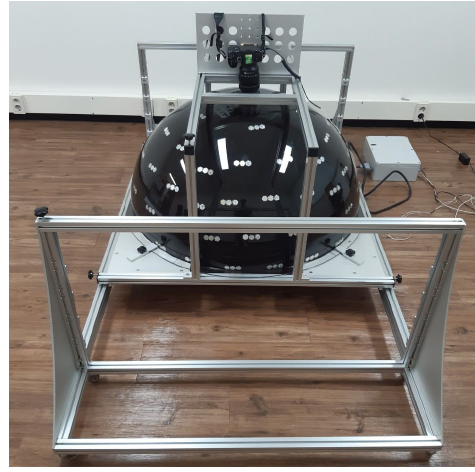
Figure 2. RTI Dome Setting with the Railed Installation